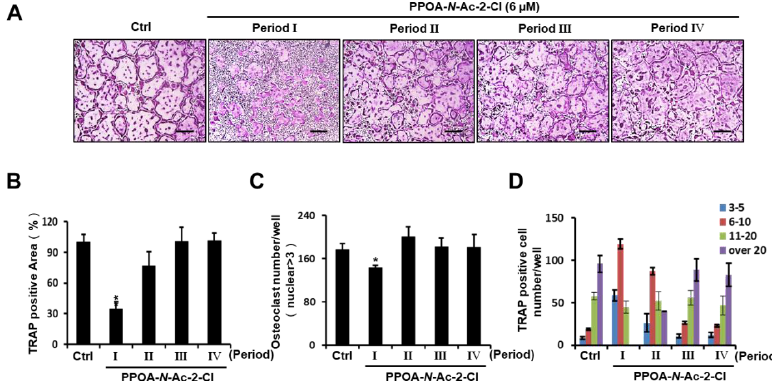
Figure 3. PPOA- N -Ac-2-Cl inhibits osteoclastogenesis at early stages of osteoclast di ff erentiation. ( A ) BMMs were seeded for five groups (Ctrl, and Periods I–IV) and cultured in the induction medium, containing M-CSF (30 ng / mL) and RANKL (50 ng / mL) for four days. The BMMs of Periods I–IV were treated with 6 µ M PPOA- N -Ac-2-Cl for 24 h on di ff erent days, day 1, 2, 3, or 4, respectively. After four days, the cells in all groups were fixed and TRAP staining was performed to determine the presence of osteoclasts. Scale bar = 200 µ m. ( B – D ) Graphs indicating the calculation of panel ( A ). The area ( B ) and total number ( C ) of TRAP-positive cells, and TRAP positive cell number based on the number of nuclei ( D ) were calculated using Image J software. * p < 0.05 versus the control